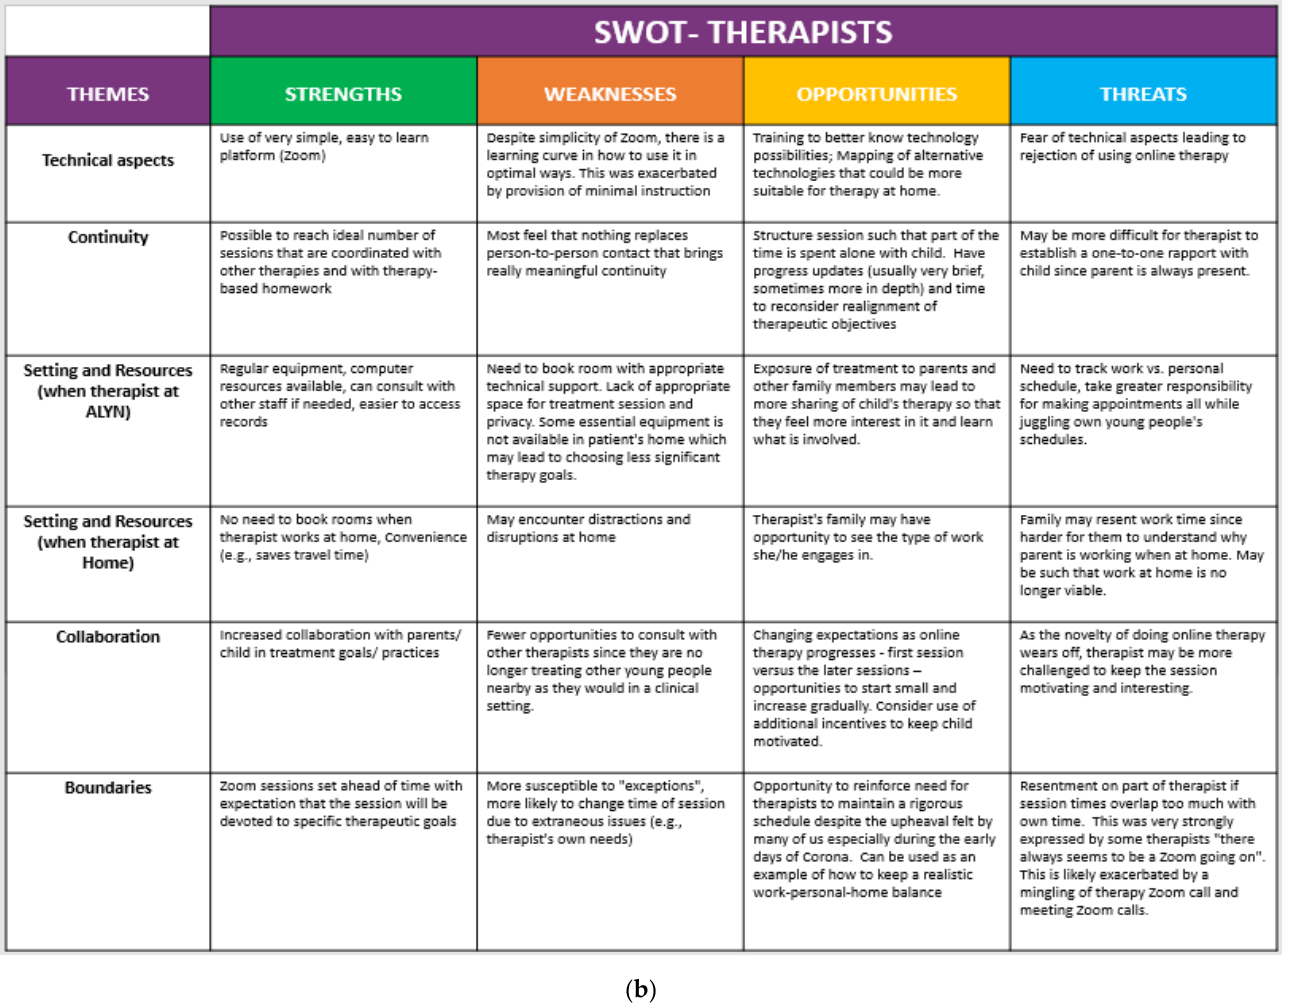
Figure 2. ( a , b ) SWOT Analysis-Families and therapists. ( a ) SWOT Analysis-Families. ( b ) SWOT Analysis-Therapists.